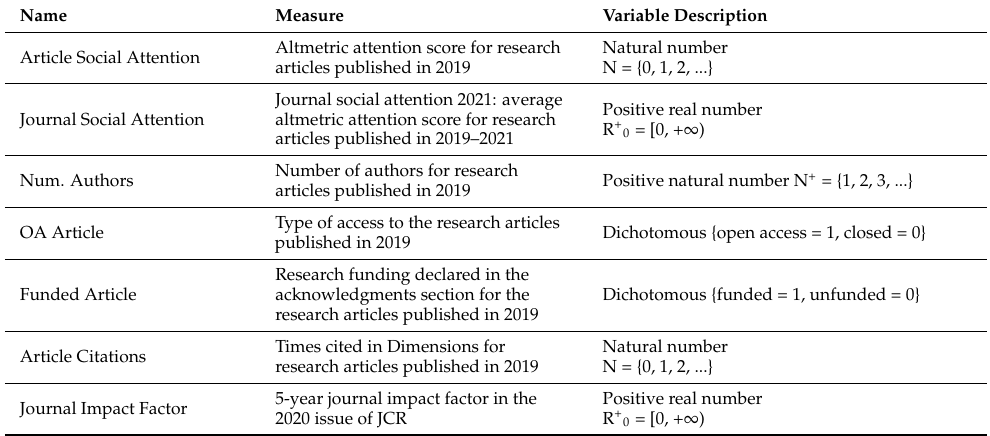
Table 3. Variables and description in the Multiple Linear Regression model.